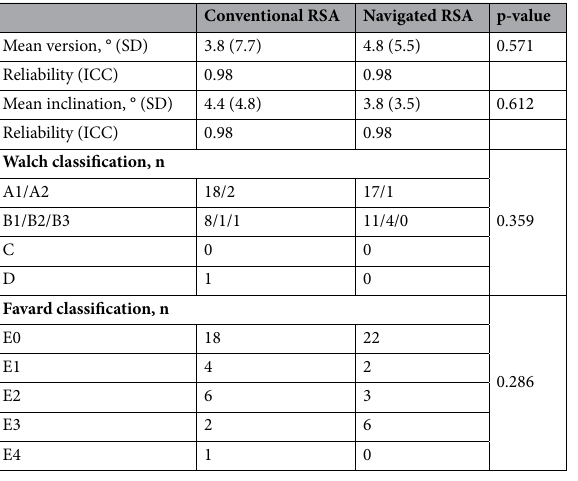
Table 2. Glenoid morphology. SD standard deviation, ICC intraclass correlation coefficient, n number. p < 0.05 is considered statistically